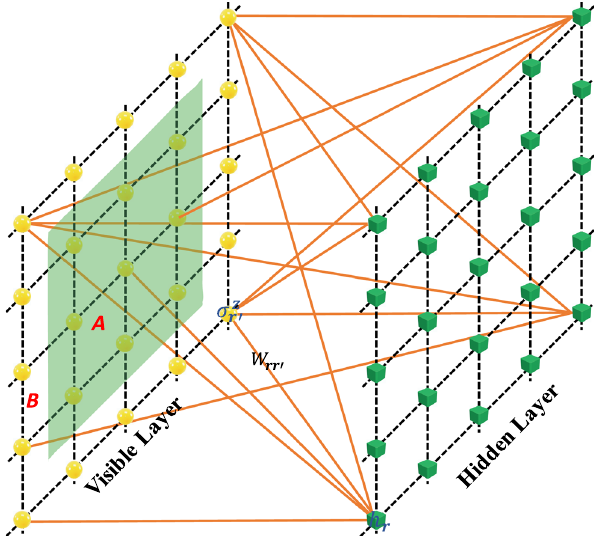
FIG. 1. A 2D pictorial illustration of artificial-neural-network quantum states in the restricted-Boltzmann-machine architecture. The yellow balls (green cubes) denote the neurons on the visible (hidden) layer, corresponding to the physical (auxiliary) spins. The brown lines show the connections between visible and hidden neurons, with the weight parameter denoted by W rr 0 (only a small portion of the connections are shown for the best visualization). Here, we also show a typical bipartition of the system into two subsystems A and B in order to study the entanglement properties of the neural-network